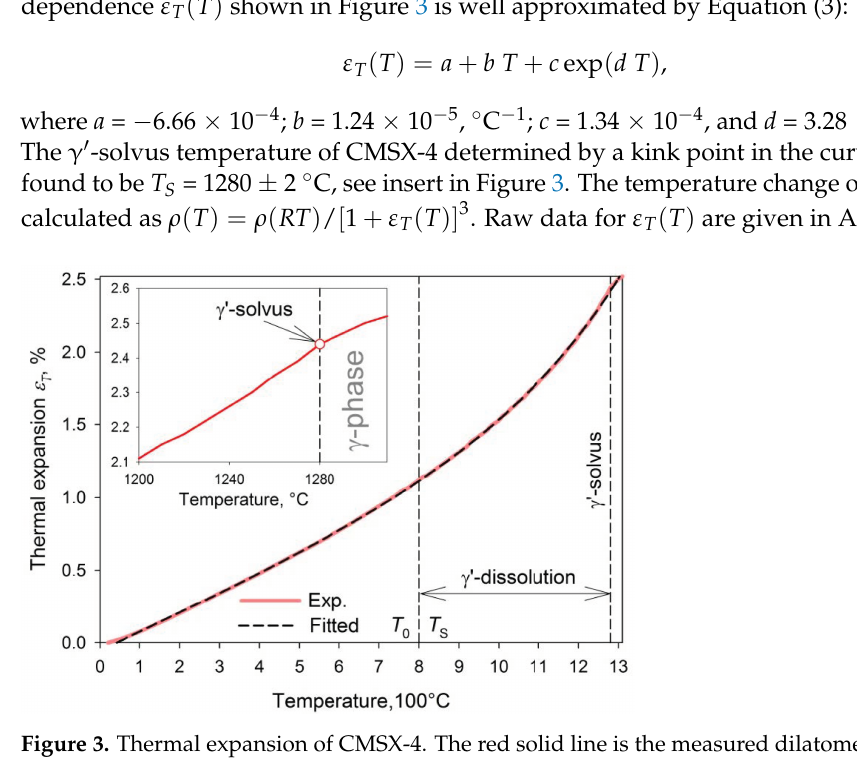
Figure 3. Thermal expansion of CMSX-4. The red solid line is the measured dilatometric curve and the black dashed line is the approximation with Equation (3). Kink of the dilatometric curve shown in the insert indicates the γ (cid:48) -solvus temperature of CMSX-4 equal to 1280 ◦